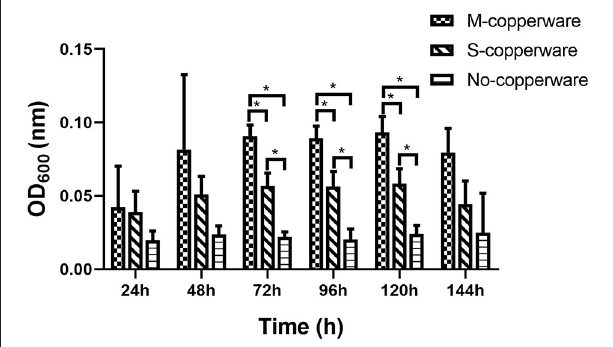
FIGURE 6 | Turbidity of water in experiment 2 assessed via spectrophotometer. M- copperware: 7.5 × 3.7 × 1.2cm, 4.96g; S-copperware: 3.75 × 3.7 × 1.2cm, 2.58g; No-copperware: control group with no CCCSNs in the filter. *: 0.001 < p < 0.05. Error bars are ± SD, n =